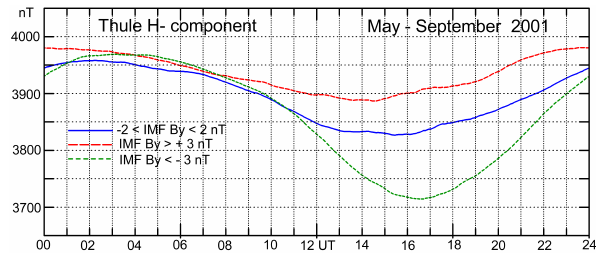
Figure 2. Mean daily variation in the H -component at Thule dur- ing summer 2001 derived for three gradations of the IMF azimuthal component: B y >3nT (red line), − 2< B y <2nT (blue line), and B y < − 3nT (green line) (cf. Fig. 5b of JT2011).